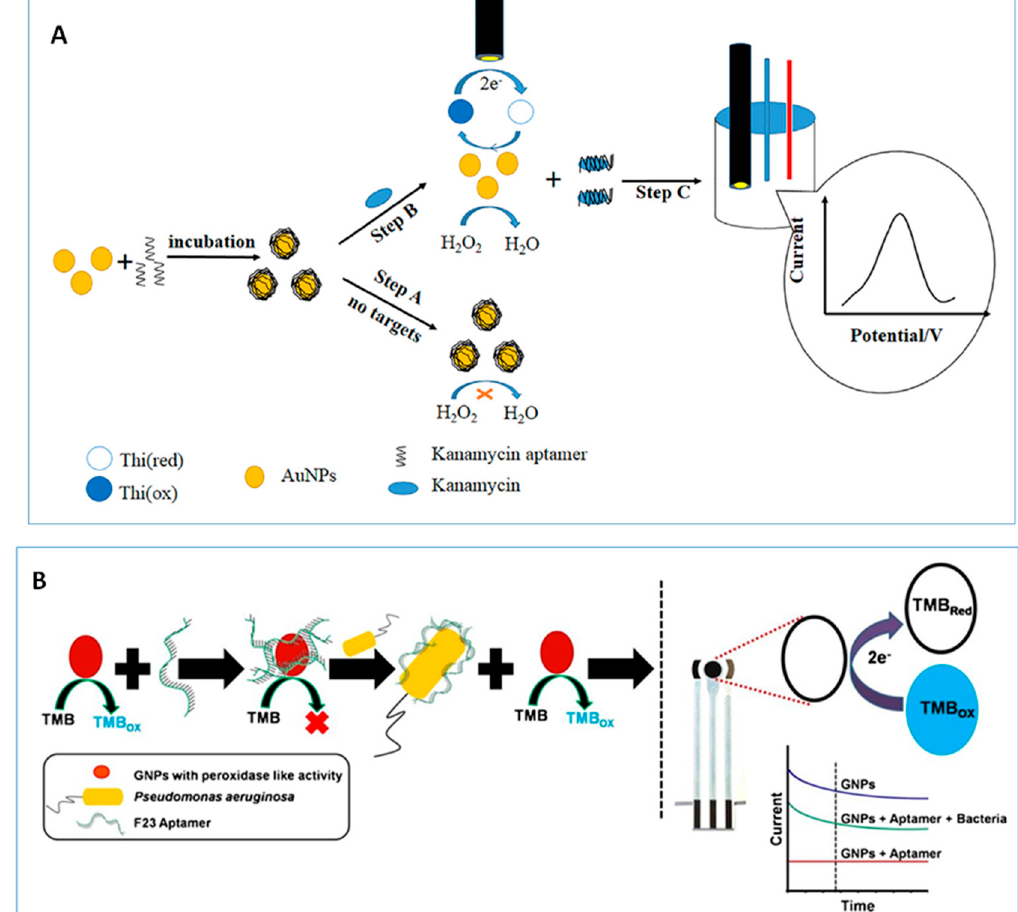
Figure 1. Scheme of aptasensing assays for the detection of kanamycin ( A ) and P. aeruginosa ( B ) using inhibition of AuNPs peroxidase activity. Reproduced from [44] ( A ) and [26] ( B ), with permission.